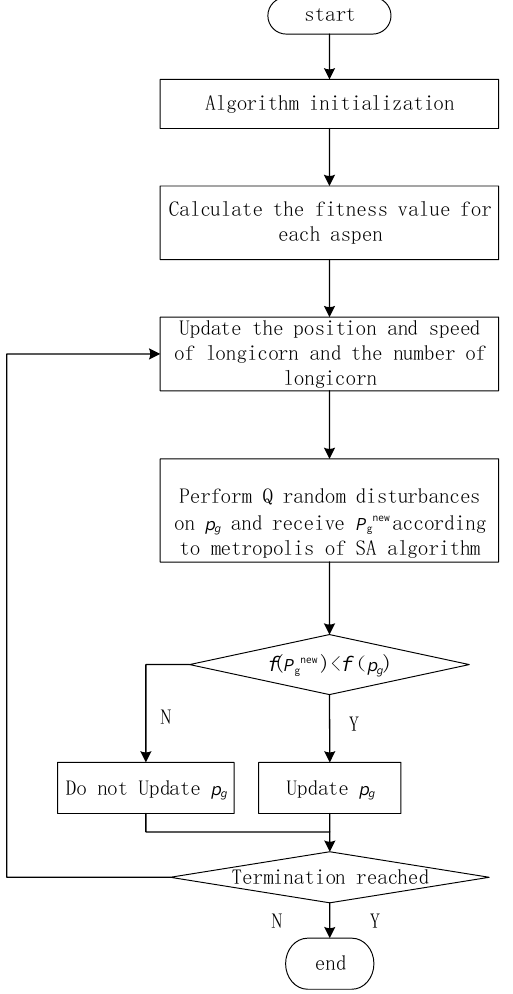
Figure 4. SEDSABSO algorithm flow chart.